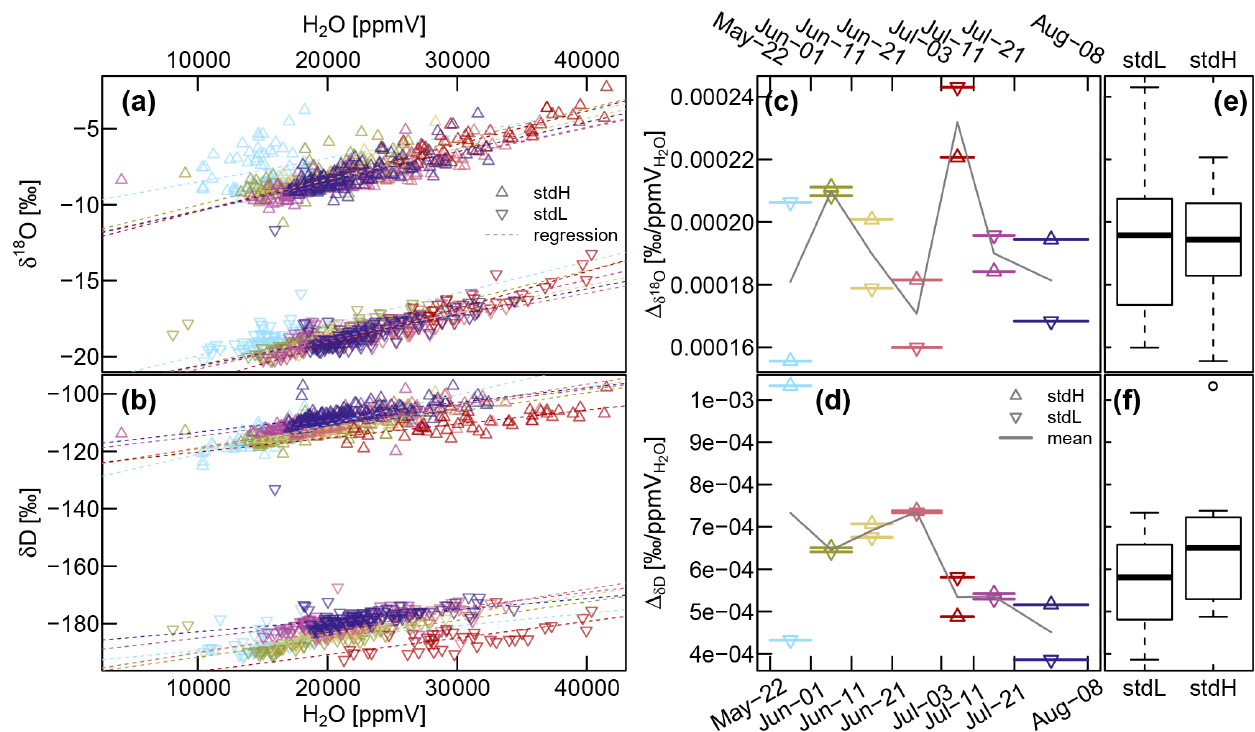
Figure A2. ( a and b ) Relationship between sample gas volumetric moisture content (H 2 O [ppmV]) and the measured isotope values assessed with the heavy standard (stdH) and the light standard (stdL). The seven colors represent specific sub-periods, as used in (c) and (d) , which show the variability of the slopes of the regression lines over time. The boxplots shown in subfigures (e) and (f) summarize this information. The blue period at the end of May indicates some starting problems, and the red period at the start of July demonstrates the effect of malfunctioning